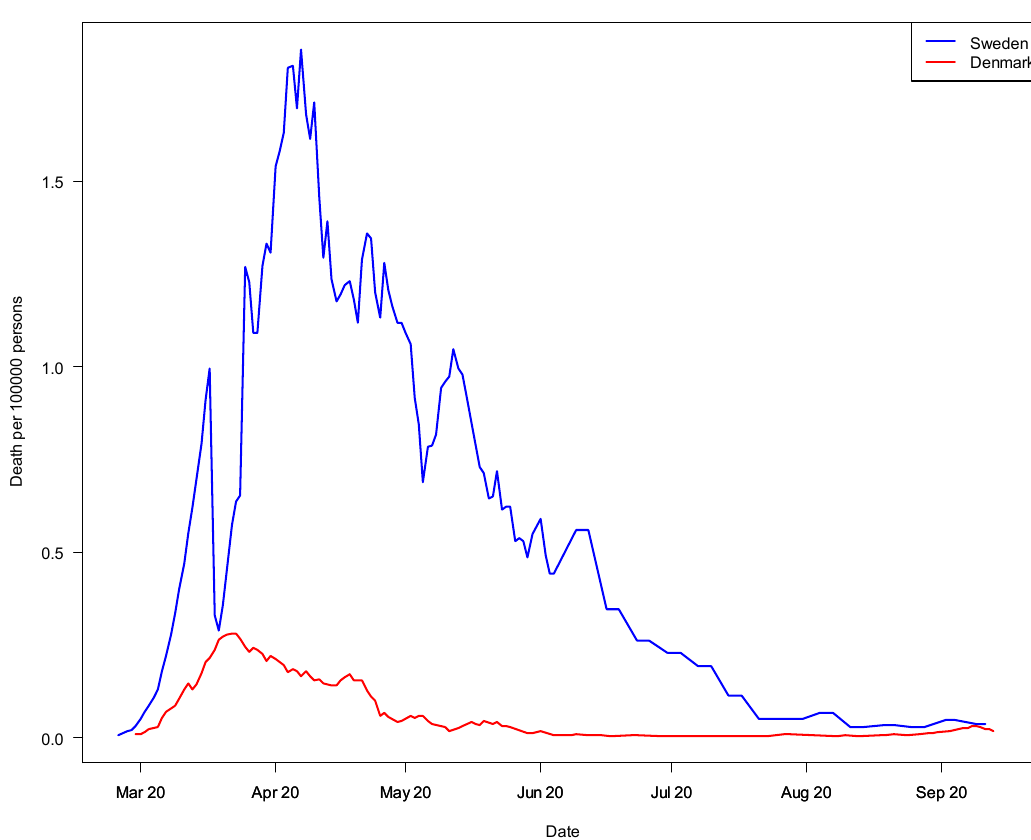
Figure 1. Number of COVID-19 deaths per 100,000 population in Denmark and Sweden, March 2020 to 1 October 2020 (Source: European Centre for Disease Prevention and Control 2021).